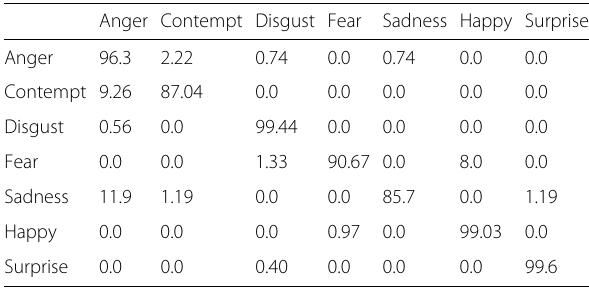
Table 14 Confusion matrix of DTCTH in case of 7-class expression recognition on